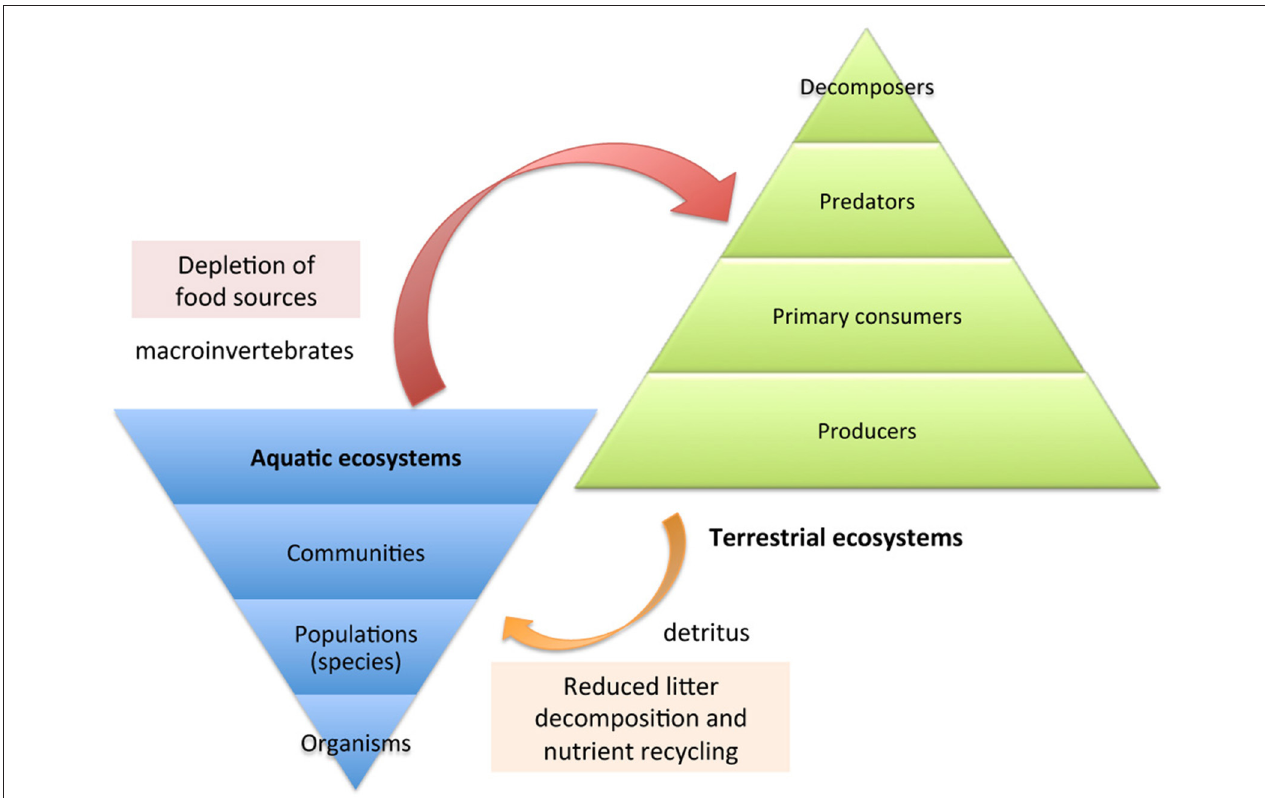
FIGURE 7 | Ecosystem impacts of water-borne neonicotinoid